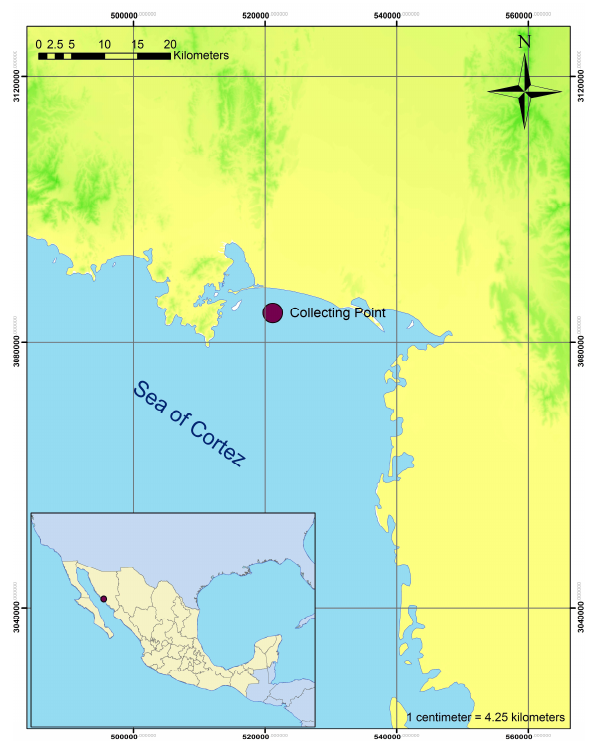
Figure 1. Map showing the location of the water collection point.